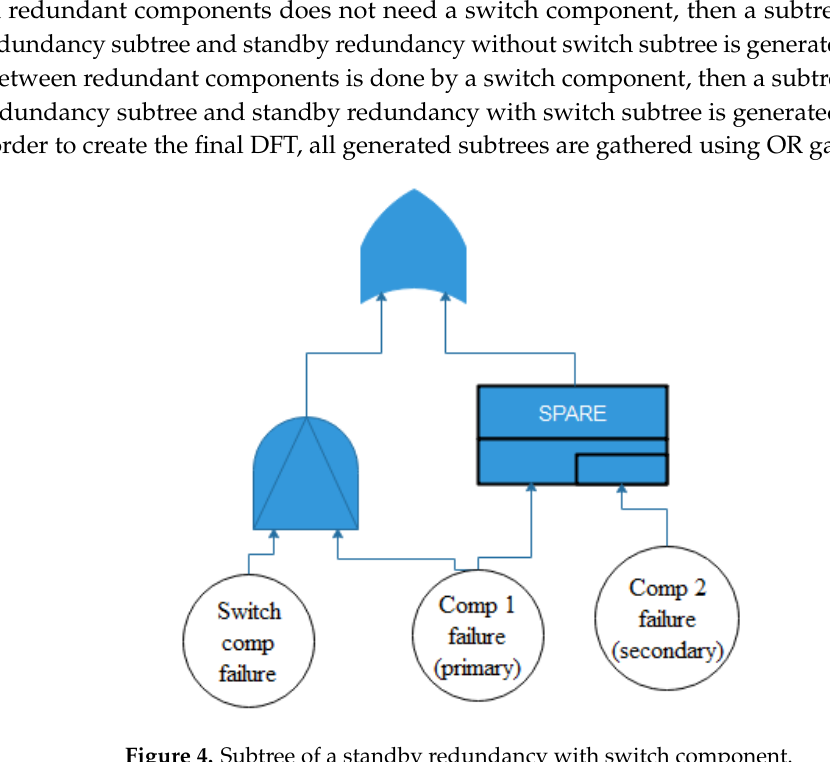
Figure 4. Subtree of a standby redundancy with switch